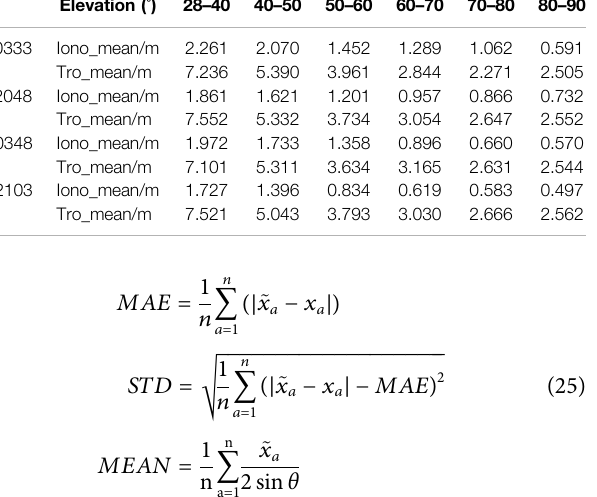
TABLE 2 | The average statistical results of the in fl uence of atmospheric delay. Elevation ( ° ) A-0333